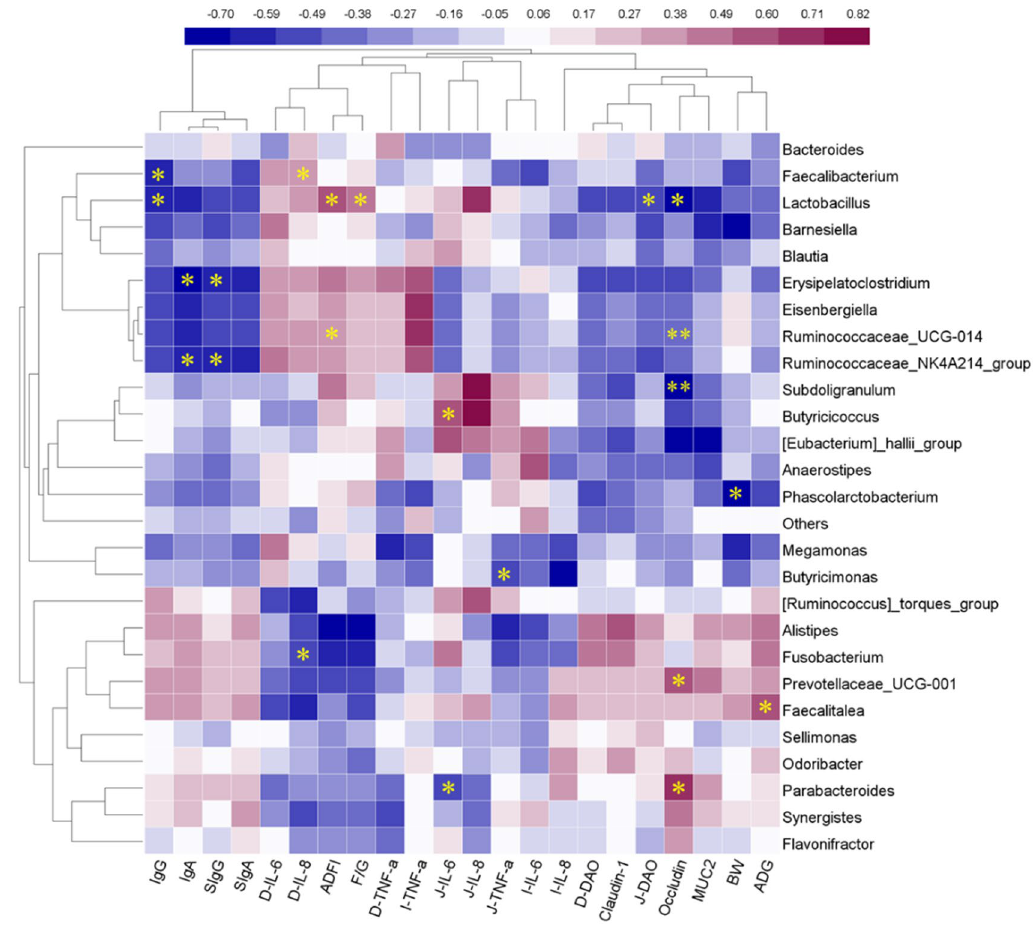
Figure 7. Correlations between significantly modified microbes (richness > 0.5%) and health parameters of broilers were analyzed by using Spearman’s correlation in SPSS Statistics 23.0 with the Bivariate correlation analysis and visualized with the heatmap (Heml 1.0.3.7, heatmap illustrator, http:// hemi. biocu ckoo. org/ down. php). * P < 0.05, ** P < 0.01 (Spearman’s correlation analysis). ADG, average daily gain; ADFI, average daily feed intake; F/G, ratio of ADFI to ADG; BW, body weight; IgG, Immunoglobulin G; IgA, Immunoglobulin A; sIgA, secretory IgA; sIgG, secretory IgG; D-IL-6, duodenal interleukin 6; D-IL-8, duodenal interleukin 8; D-TNF-α, duodenal tumor necrosis factor-α; J-IL-6, jejunal interleukin 6; J-IL-8, jejunal interleukin 8; J-TNF-α, jejunal tumor necrosis factor-α; I-IL-6, ileal interleukin 6; I-IL-8, ileal interleukin 8; I-TNF-α, ileal tumor necrosis factor-α; D-DAO, duodenal diamine oxidase; J-DAO, jejunal diamine